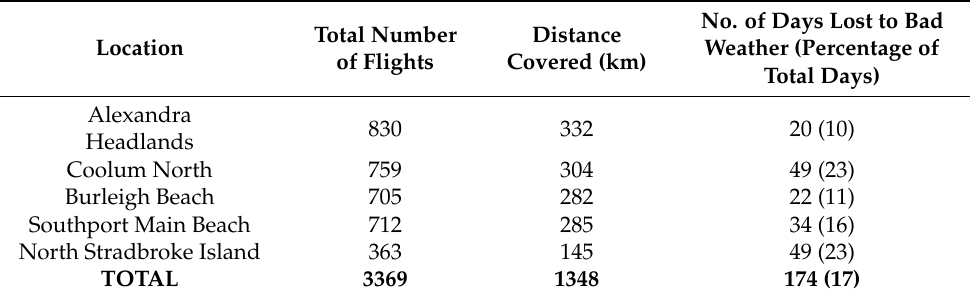
Table 2. Operational metrics for each beach covered by the Queensland SharkSmart drone trial. Data